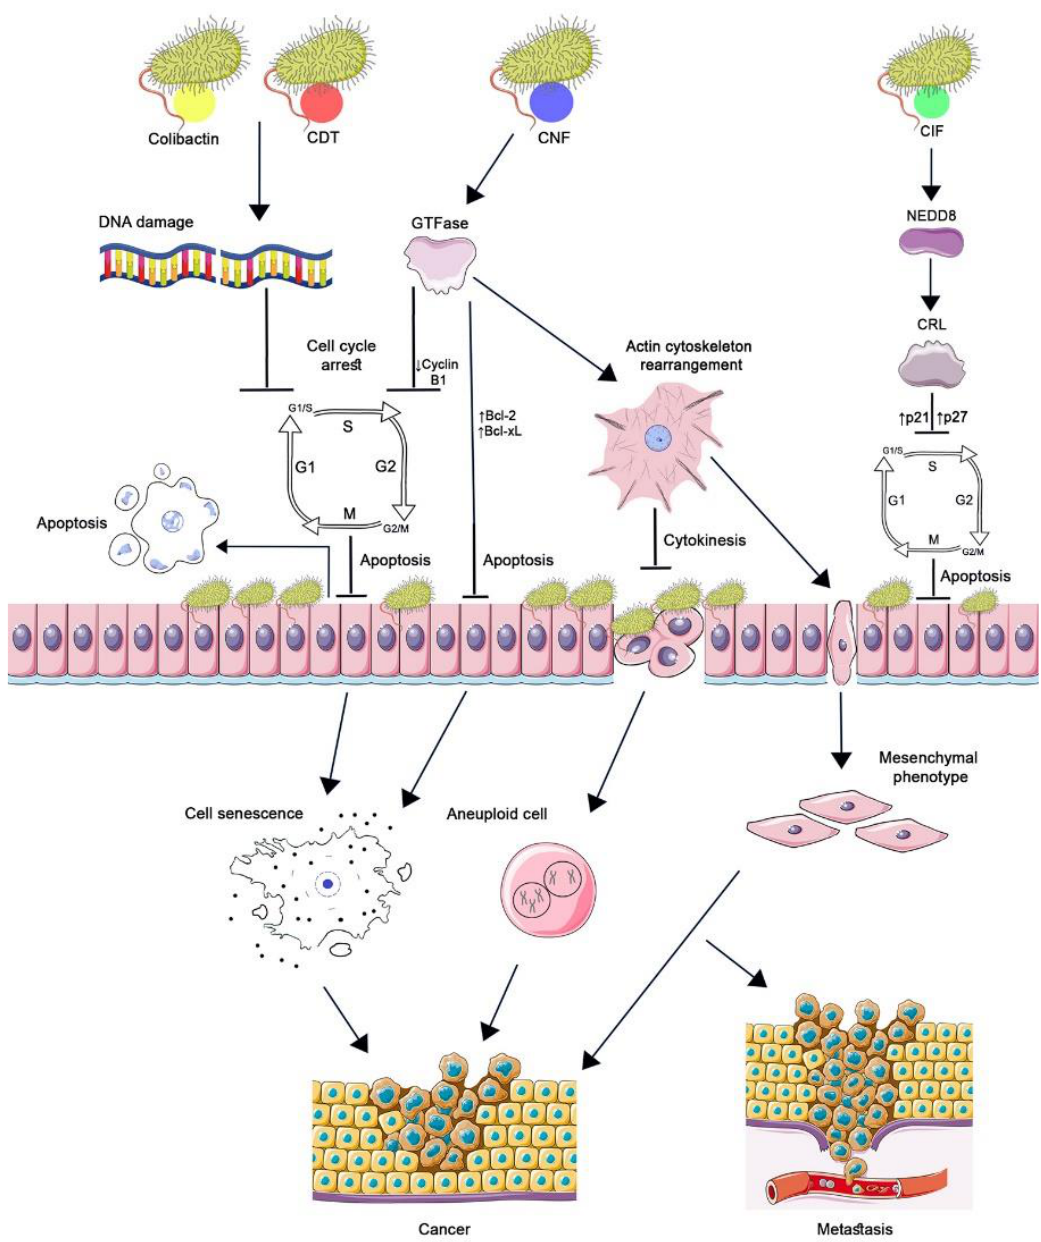
Figure 1. The role of cyclomodulins in carcinogenesis. CNF1, activating Rho GTPases, causes changes in the actin cytoskeleton, which leads to blocking of cytokinesis and the occurrence of aneuploidy and the epithelial-mesenchymal transition of cells. GTPases suppress the expression of cyclin B1 by arresting the cell cycle in the G2/M phase and increasing the transcription of Bcl-2 and Bcl-XL factors without triggering apoptosis. Aneuploidy, senescence, and the acquisition of a mesenchymal phenotype by cells lead to the development and progression of cancer. CIF, by binding to the ubiquitin-like protein NEDD8, inhibits the activity of CRL ubiquitin ligase. As a result, p21 and p27 accumulate in the cell, which leads to cell cycle arrest, prevention of eukaryotic cell proliferation, and delayed apoptosis. The genotoxins colibactin and CDT cause DNA damage resulting in cell cycle arrest at the G1/S and G2/M checkpoints. Cell growth and cell renewal arrest facilitate bacterial colonization. The cellular response to significant DNA damage consists either in the development of apoptosis or in the formation of a cellular senescence phenotype. Incomplete DNA repair of surviving cells leads to genomic instability, initiation of tumor development, and/or increased tumor growth. (Figure 1 was created using the images from Servier Medical Art https://smart.servier.com/ 26 June